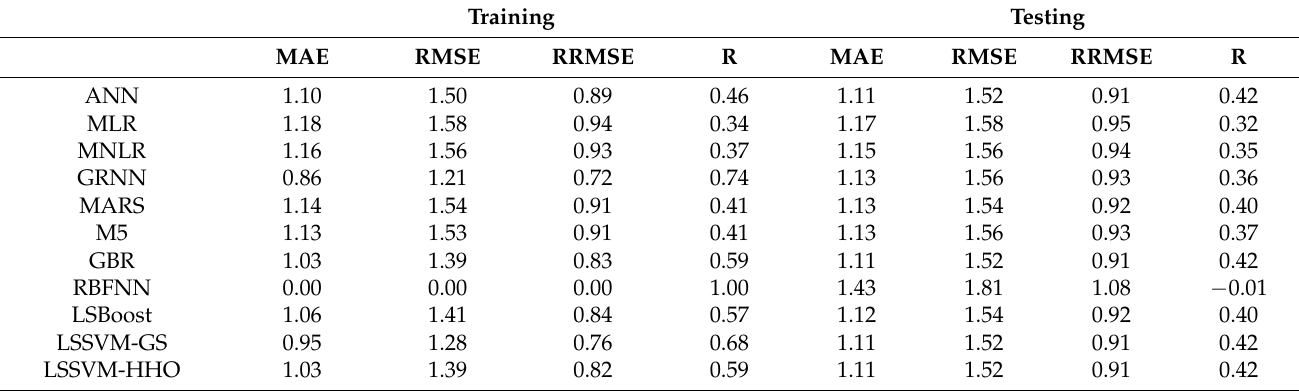
Table A1. Results of modeling WS with the base algorithms at the Sarakhs station.